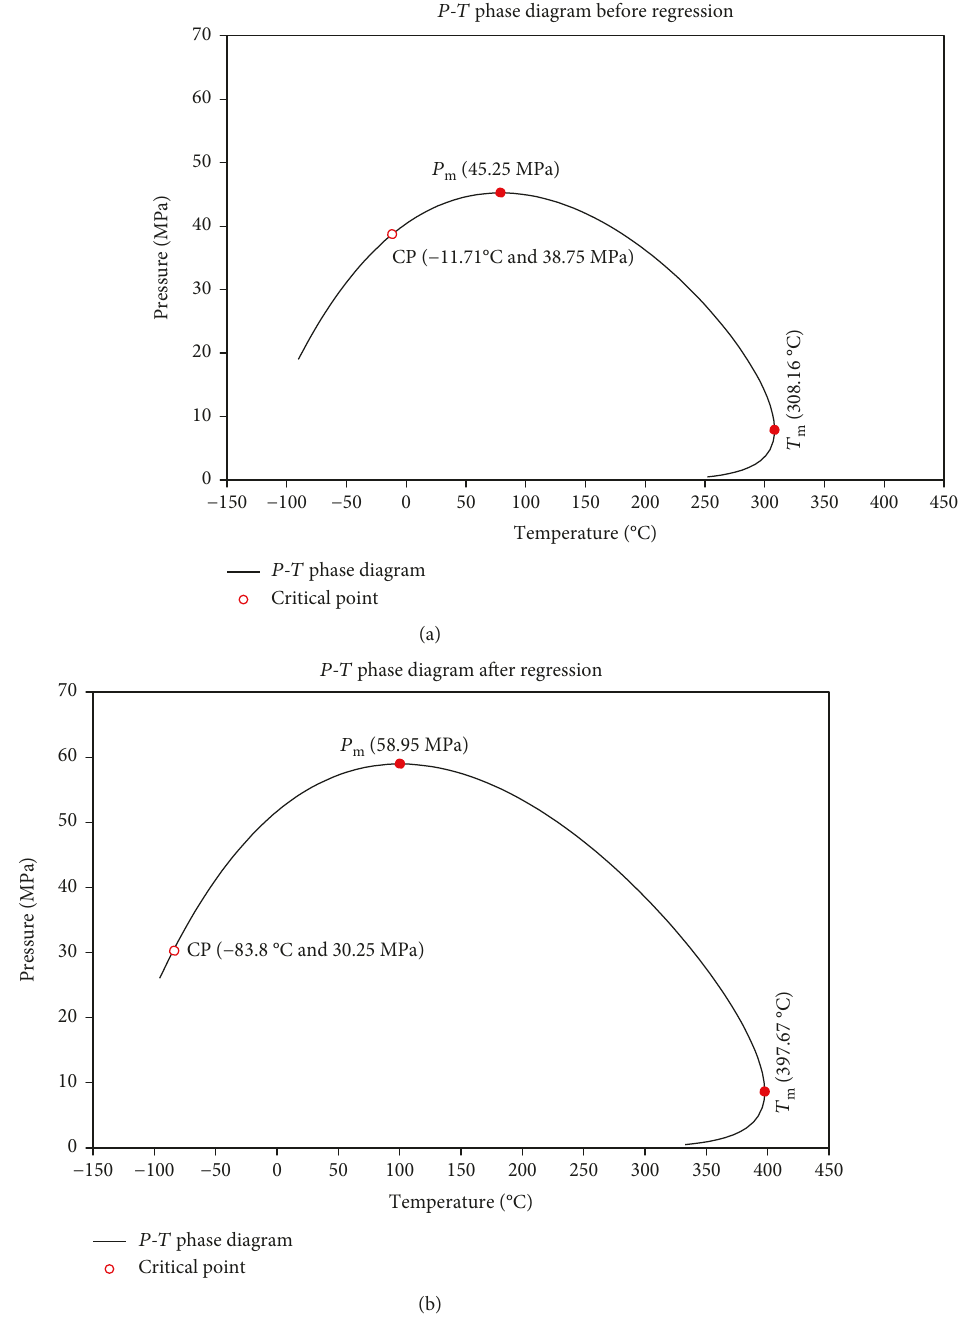
Figure 2: The original P ‐ T phase diagram (before regression) and the fi nal P ‐ T phase diagram (after